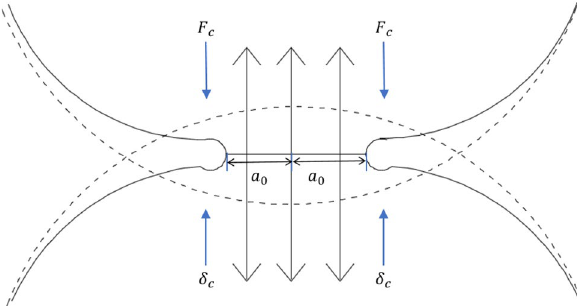
Figure 2. Contact diagram between particles in JKR contact